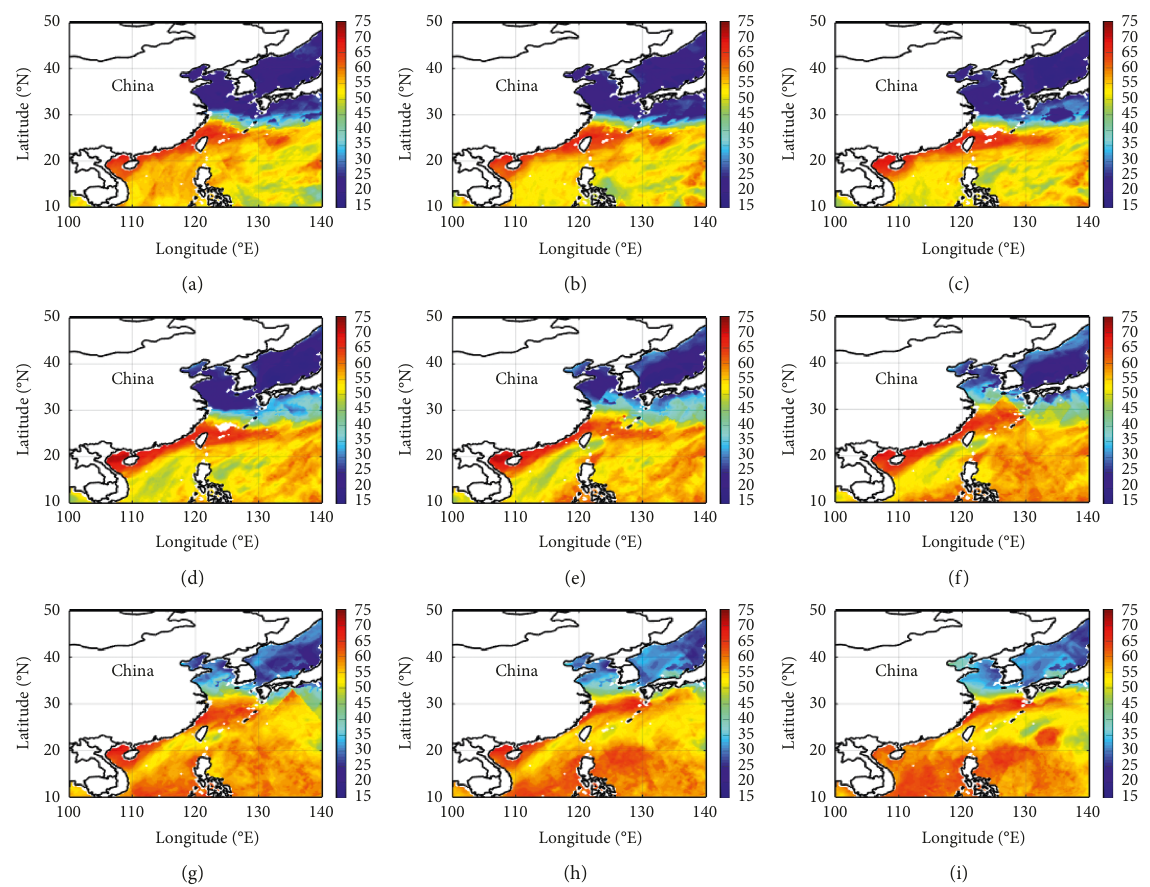
Figure 9: Evolution of PWV maps derived from GMI 3-day composites from 15 to 23 June 2017. (a) 15 June 2017. (b) 16 June 2017. (c)